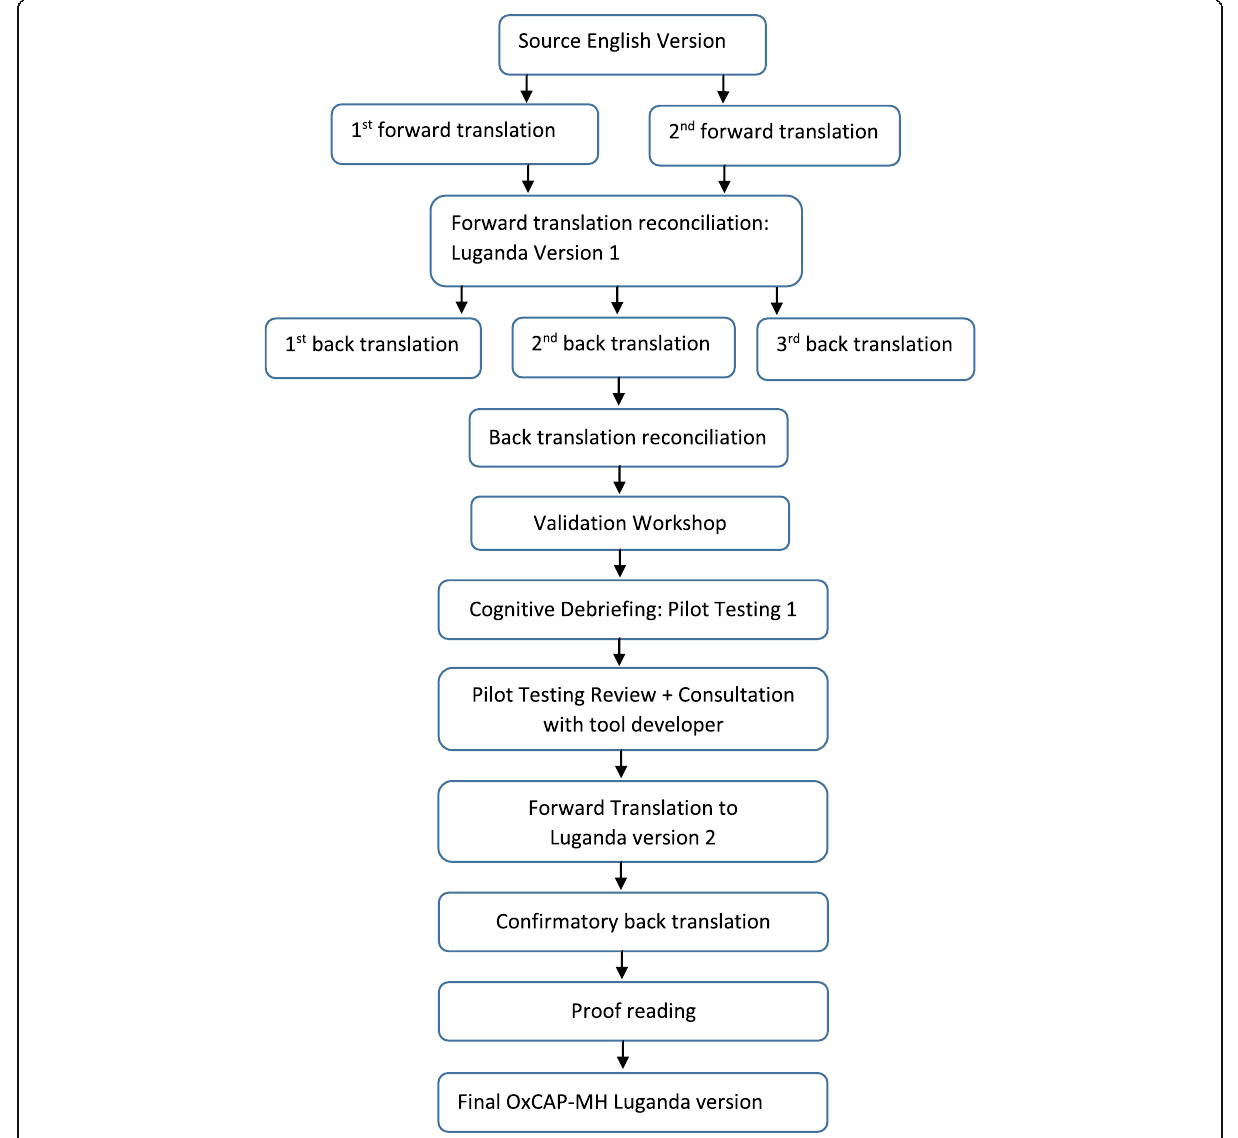
Fig. 1 Translation of the Source OxCAP-MH English version into Luganda according to the Translation and Linguistic Validation